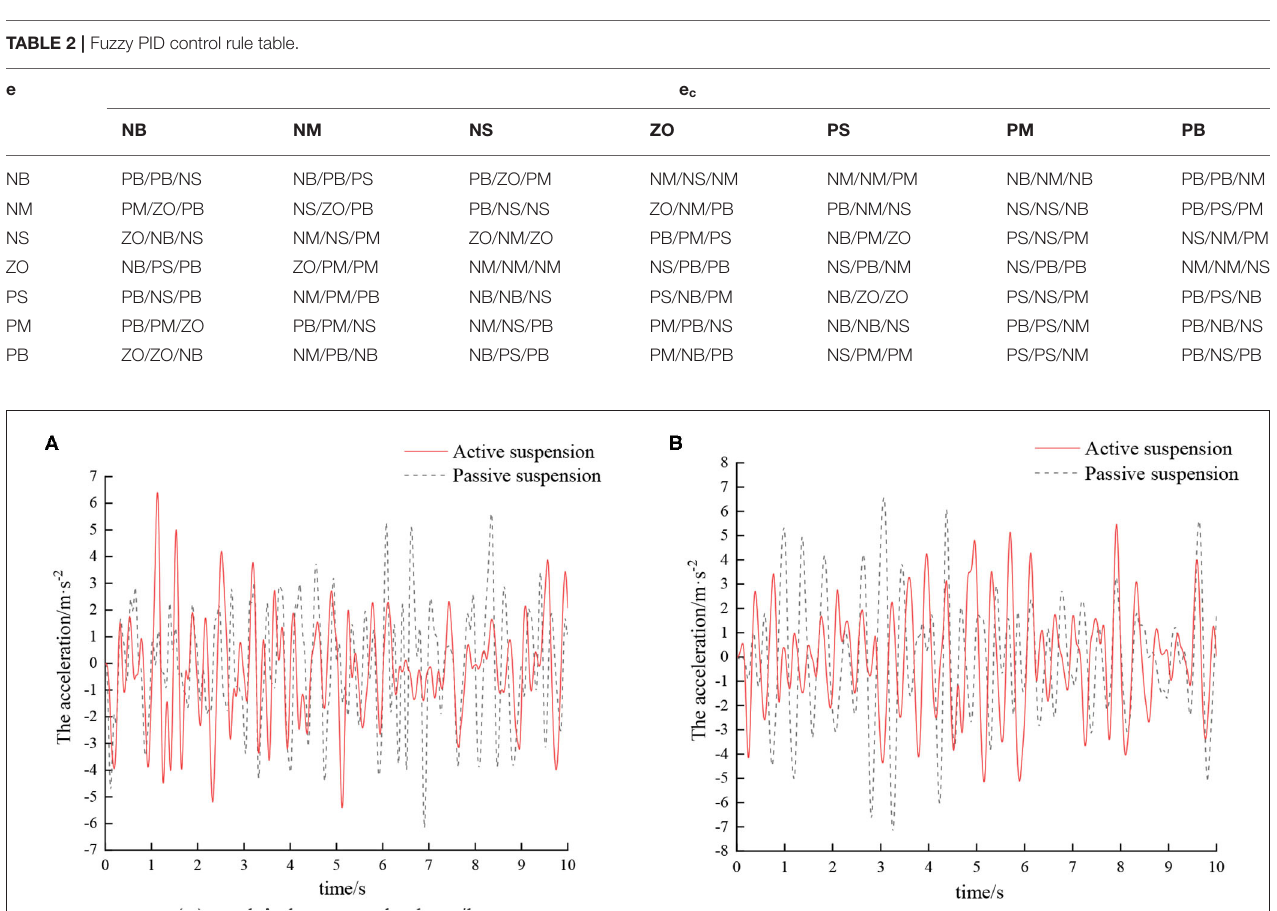
The optimized fuzzy rule table is shown in Table 2 .